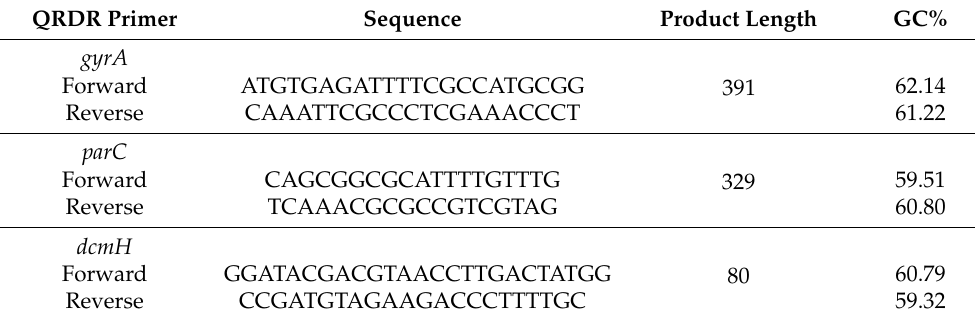
Table 5. The sequences of the gyrA , parC , and dcmH gene